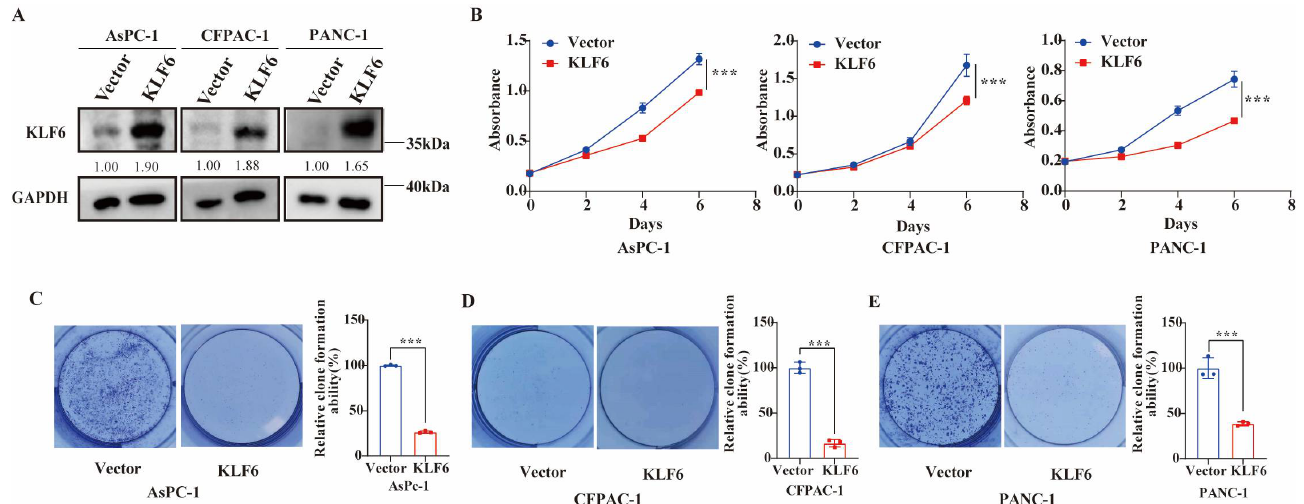
Figure 2. Overexpression of KLF6 inhibits proliferation of pancreatic cancer cells. ( A ) Western blot test results showing KLF6 protein expression level (KLF6-3xFlag) after KLF6-overexpression plasmid transfection of AsPc-1, CFPAC-1, and PANC-1 cells. ( B ) Cell proliferation of AsPc-1, CFPAC-1, and PANC-1 cells after KLF6 overexpression measured by CCK8 assays. Data represent mean ± SD; n = 6. *** p < 0.001. ( C – E ) Cell proliferation of AsPc-1, CFPAC-1, and PANC-1 cells after KLF6 overexpression measured by clone formation assays. Data represent mean ± SD; n = 3. *** p < 0.001.